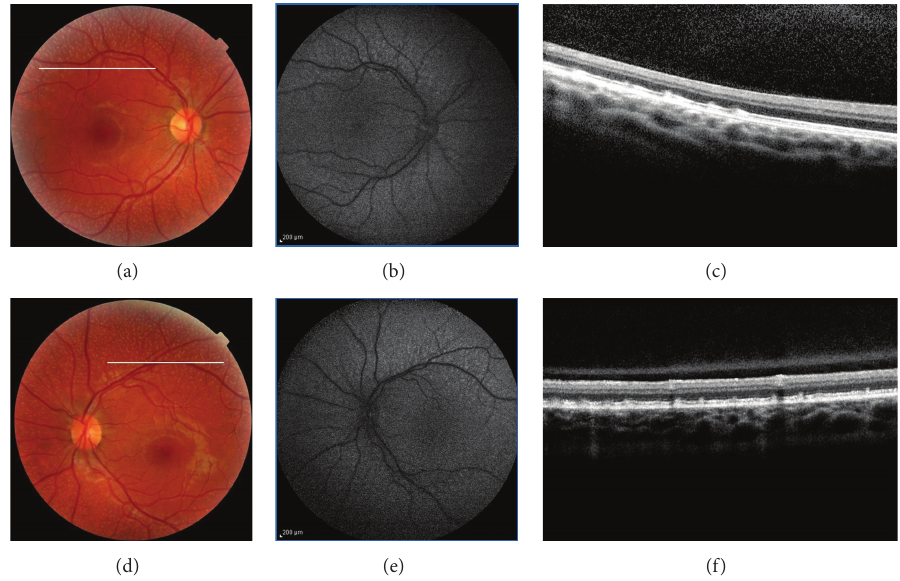
Figure 7: Fundus photograph of two eyes with fundus albipunctatus shows many small white dots scattered throughout the retina except for the foveal area. Fundus autofluorescence imaging of both eyes produced fuzzy and grainy images, and the margins of the optic nerve head and blood vessels are blurred. On SD-OCT, focal thickening centered in the photoreceptor OS and extending forward close to the outer limiting membrane and backward to the outer aspect of the RPE is seen corresponding to the multiple discrete albipunctate dots. These lesions seem to bulge their outer and inner boundaries. There was a reduced visualization of the photoreceptor outer